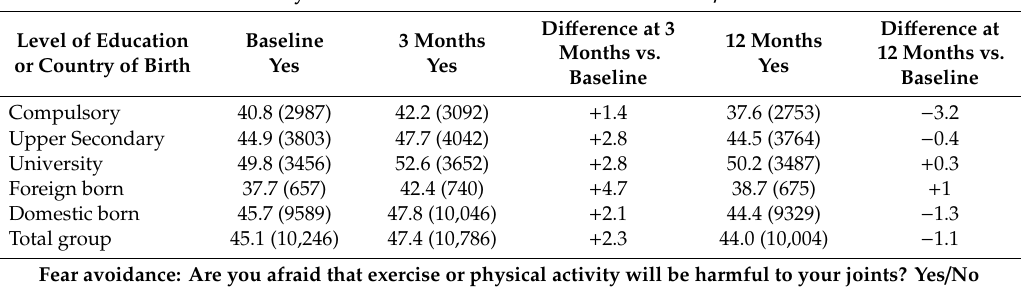
Table 3. Descriptive results for outcome variables related to health-related behaviours and adherence to the self-management program ( n = 22,741).